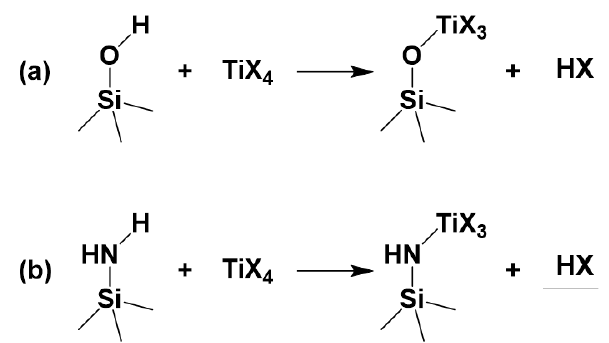
Figure 2. Suggested adsorption mechanism of TiX 4 on: ( a ) –OH functionalized Si cluster; and ( b ) –NH 2 functionalized Si cluster.